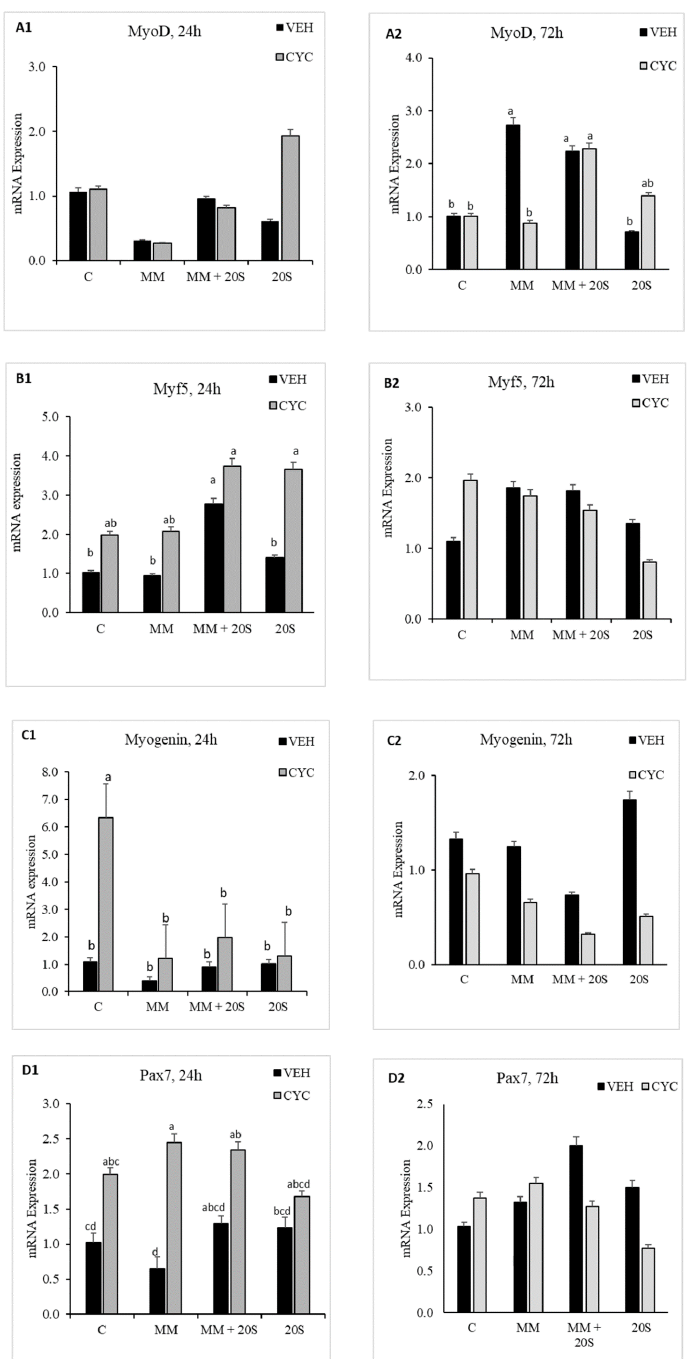
Figure 9. Hedgehog signaling pathway inhibitor, Cyclopamine, did not block the inhibitory effect of 20S on myogenic differentiation of chicken bone marrow stem cells (cBMSCs). When confluent, cBMSCs were pretreated for 2 h with control vehicle (VEH) or 4 µM cyclopamine (CYC), followed by 24 h and 72 h of treatment with (1) Control (C), (2) myogenic media (MM) containing DMEM with 5% Horse Serum, 10 µM Hydrocortisone, and 0.1 µM DXA, (3) MM + 2.5 µM 20S, (4) MM + 5 µM 20S, and (5) MM + 10 µM 20S. RNA was isolated, reverse transcribed to cDNA, and q RT-PCR was conducted to analyze osteogenic gene expression. GAPDH was used as a housekeeping gene. Fold changes in gene expression relative to the control were calculated using the −ΔΔ Ct method. mRNA expression of ( A1 , A2 ) MyoD, ( B1 , B2 ) Myf5, ( C1 , C2 ) Myogenin, and ( D1 , D2 ) Pax7 are presented above. Bars represent mean ± SEM of triplicate determinations. Bars without a different letter (a–b) in common are significantly different ( p < 0.05) when analyzed with Tukey’s test.